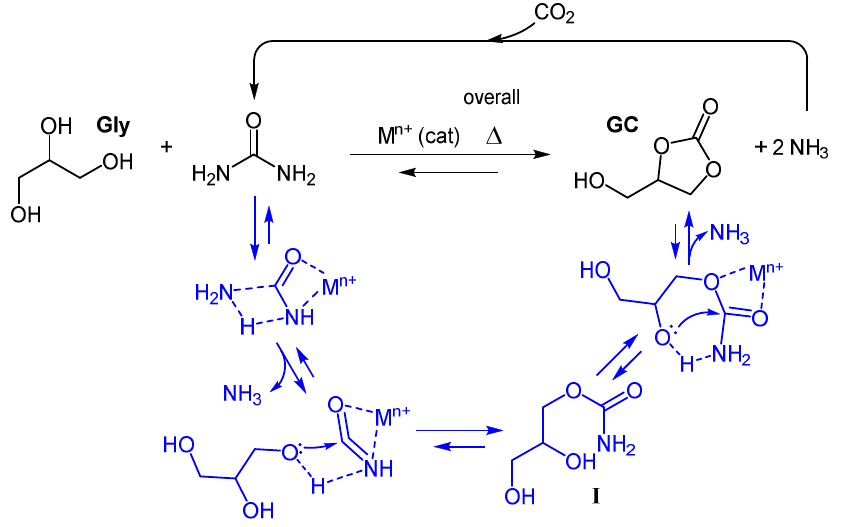
Figure 1. Metal-catalyzed carbonylation of Gly with urea.